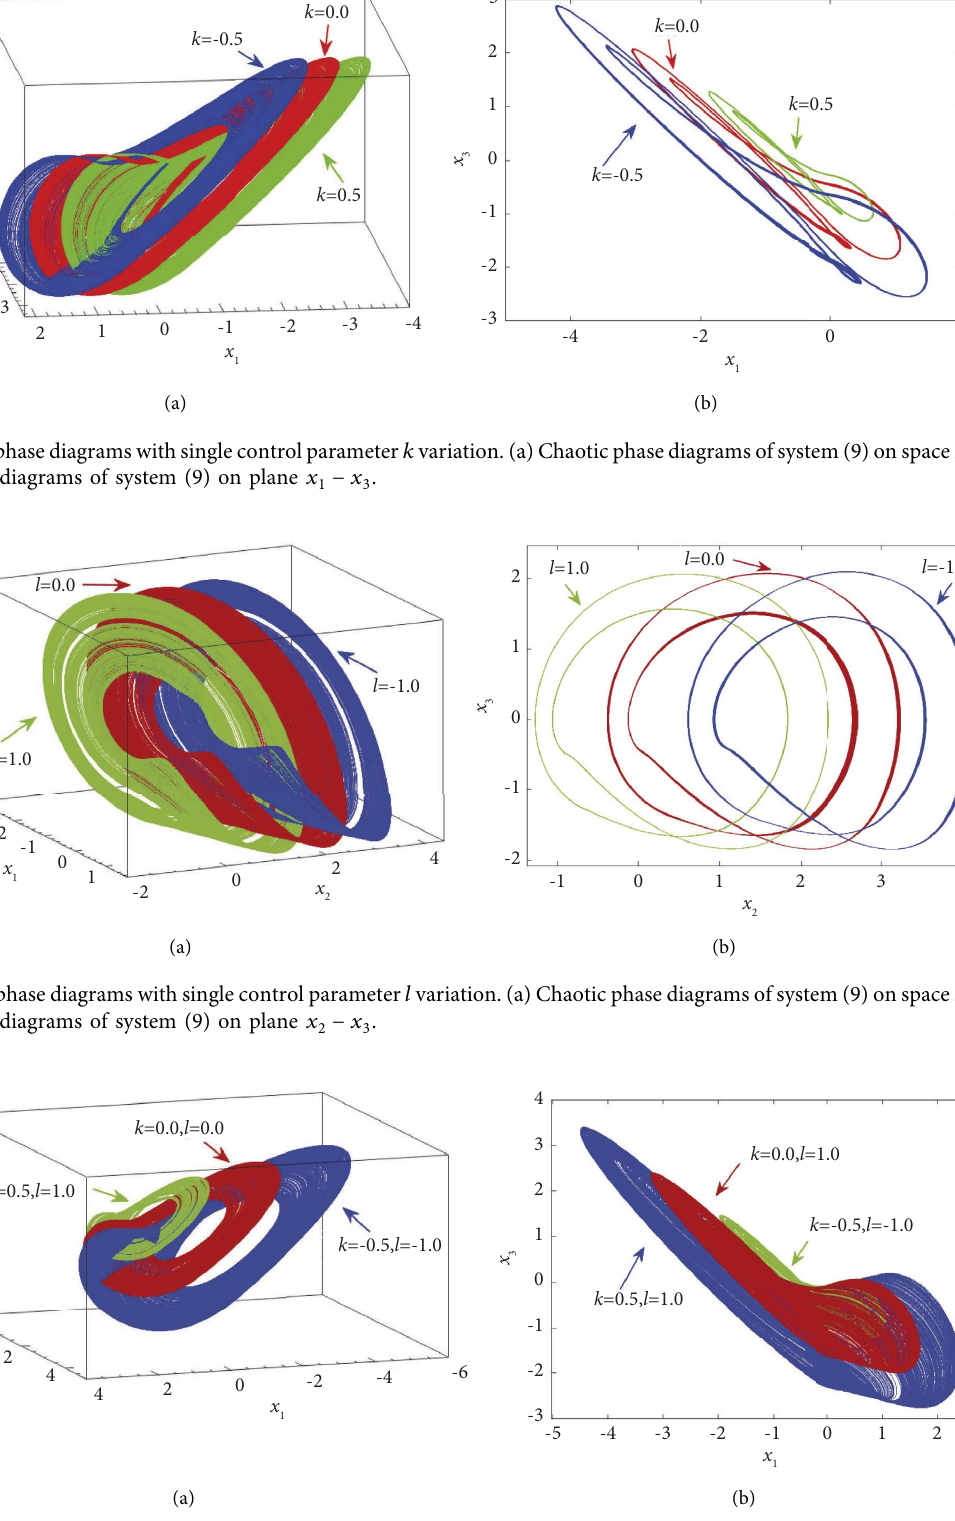
Figure 18: System phase diagrams with double control parameter k and l variation. (a) Chaotic phase diagrams of system (9) on plane x − x − x ; (b) chaotic phase diagrams of system (9) on plane x 1 2 3